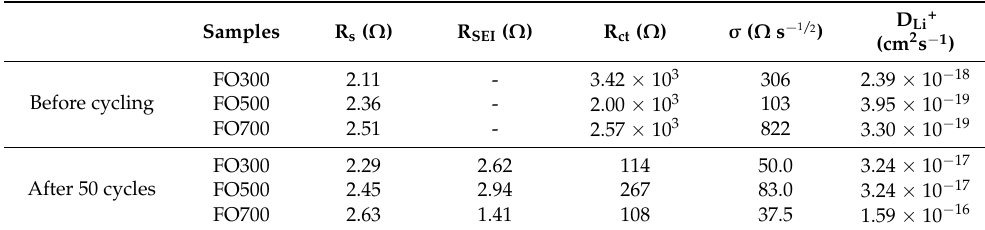
Table 1. Calculated resistances (R s , R SEI , and R ct ), Warburg coefficient ( σ ), and diffusion coefficient (D Li+ ) from the Nyquist plots and Equations (1) and